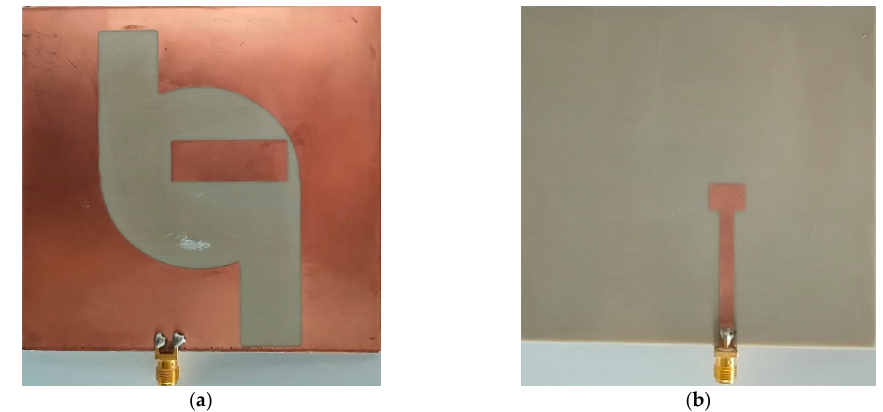
Figure 8. Fabricated antenna: ( a ) the antenna ground on the front side and ( b ) the feedline on the back side. Aerospace 2019 , 6 , x FOR PEER REVIEW